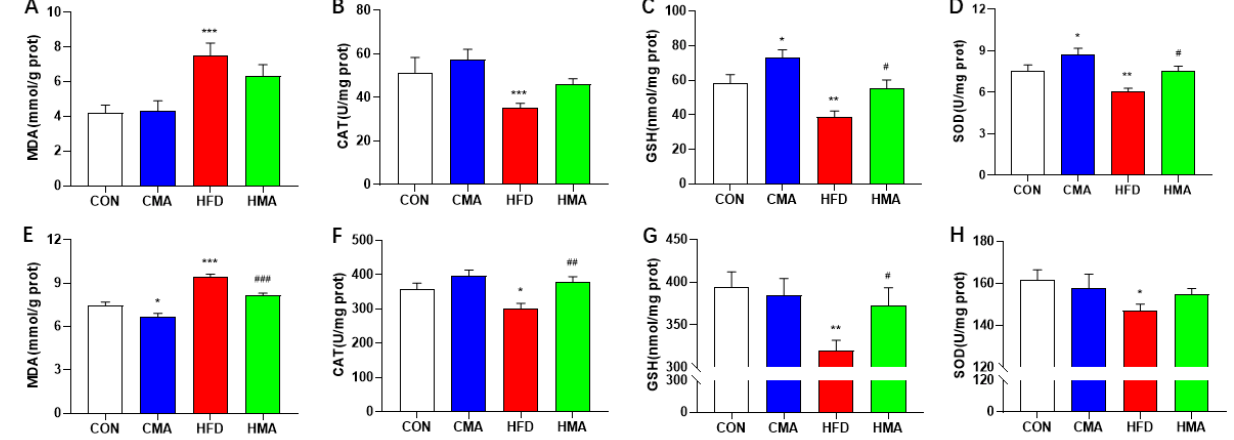
Figure 3. Effects of MA on oxidative stress in liver and EAT of mice. ( A − D ) Liver oxidative stress indicators. ( E − H ) EAT oxidative stress indicators. Values are expressed as mean ± SEM (n = 10). Differences between the CON group and the CMA and HFD groups are indicated by *. *** p < 0.001, ** p < 0.01, * p < 0.05. Differences between the HFD group and the HMA group are expressed by # ### p < 0.001, ## p < 0.01, and # p < 0.05.